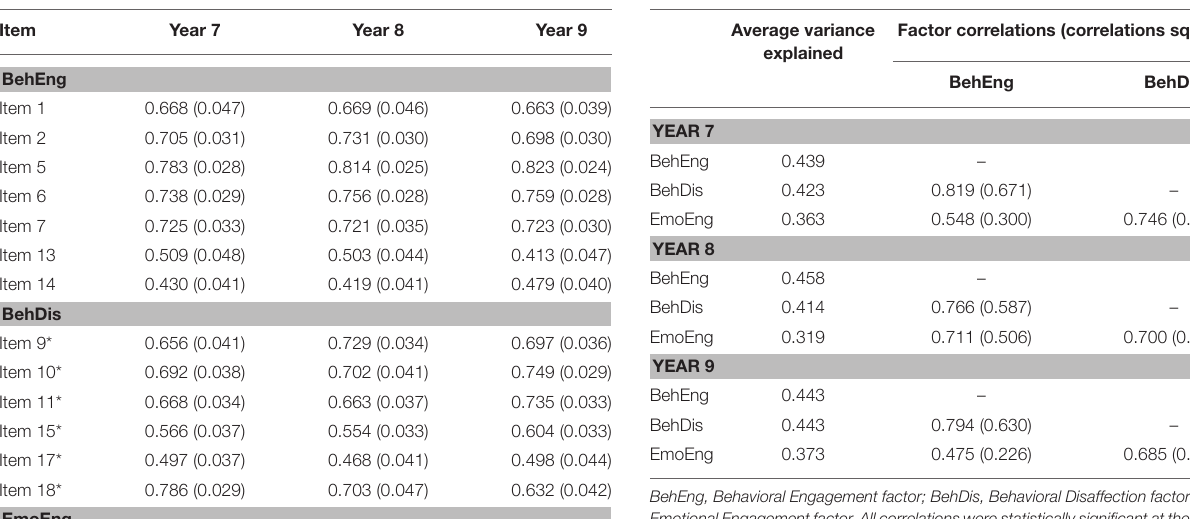
TABLE 5 | Discriminant validity analyses for the engagement measure CFA model across years 7, 8, and